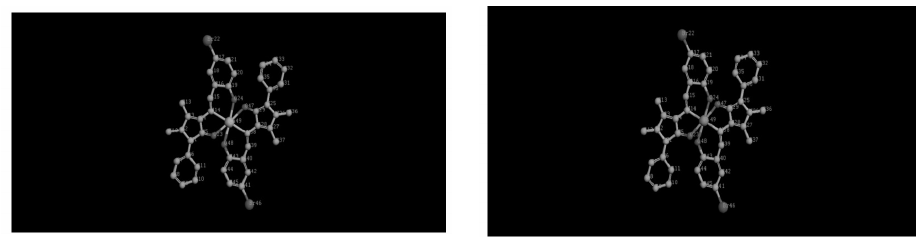
Figure 11 . Cu(II)complex Figure 12 .